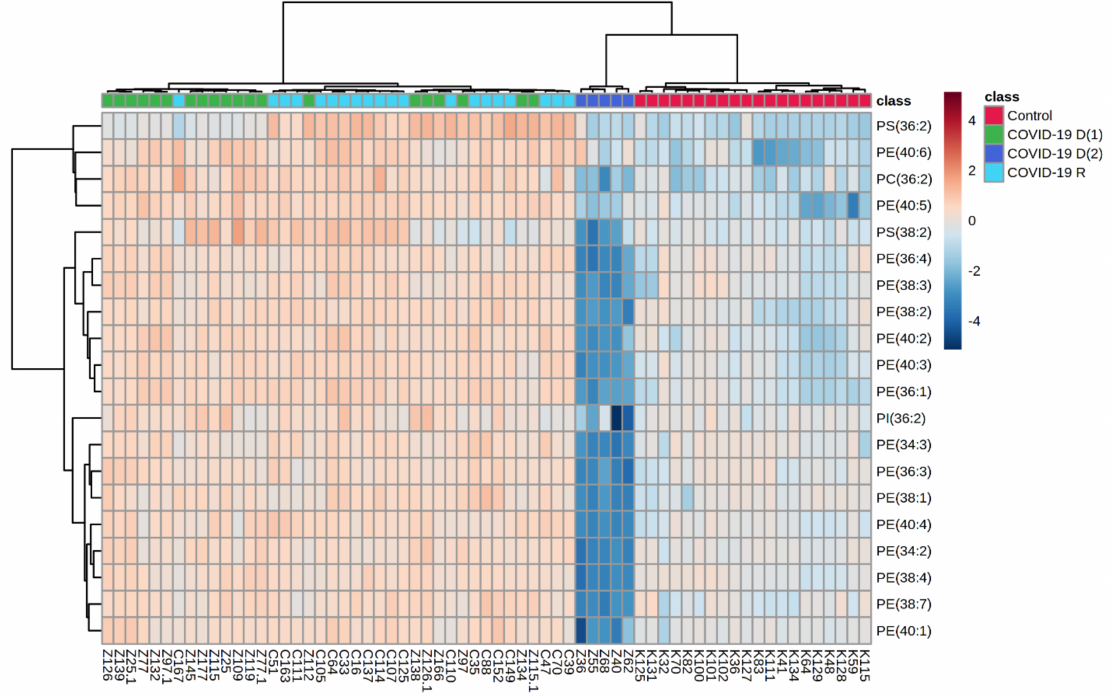
Figure 3. Two-dimensional hierarchical clustering heat map of the 20 most discriminating phospho- lipid species (according to One-way ANOVA) identified in the plasma of healthy subjects ( n = 20) [Control] , first subgroup of deceased COVID-19 patients ( n = 15) [COVID-19 D(1)] , second subgroup of deceased COVID patients ( n = 5) [COVID-19 D(2)] and COVID-19 recovered patients ( n = 20) [COVID-19 R]